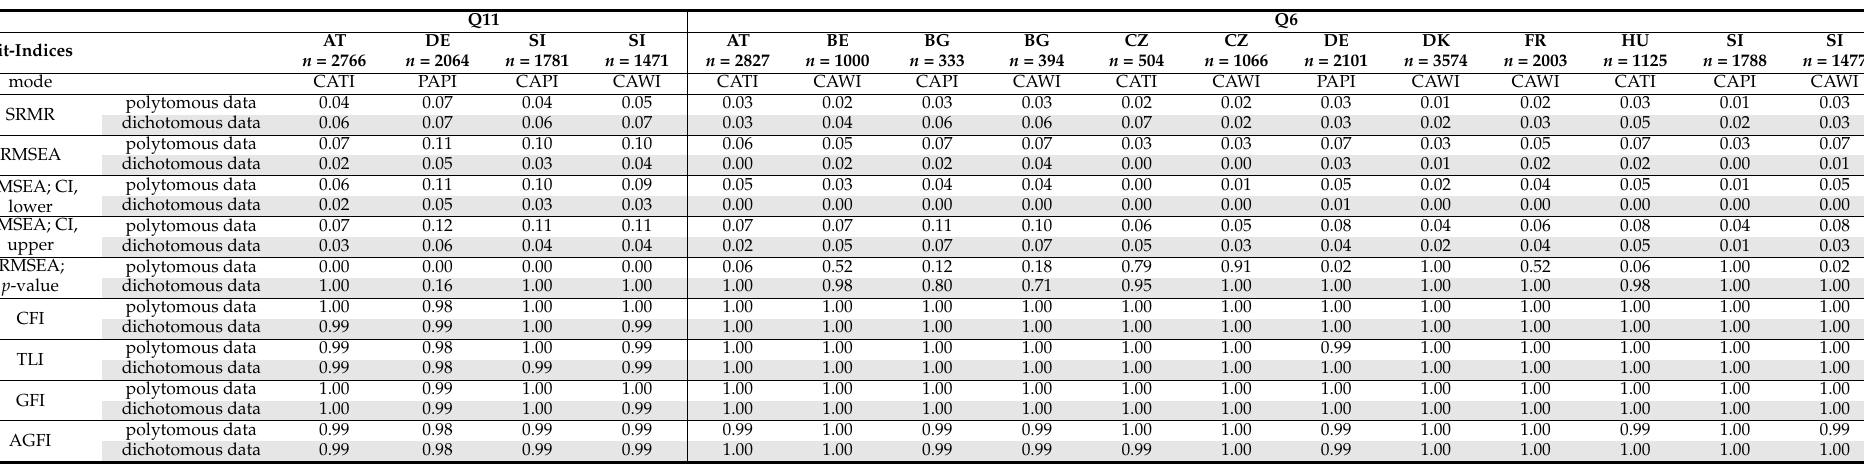
Table 5. Fit indices for the one-factor model of the HLS 19 -COM-P-Q11 (left) and HLS 19 -COM-P-Q6 (right), for each country, divided by data collection mode. Analyses are based on both polytomous and dichotomous (marked in grey)